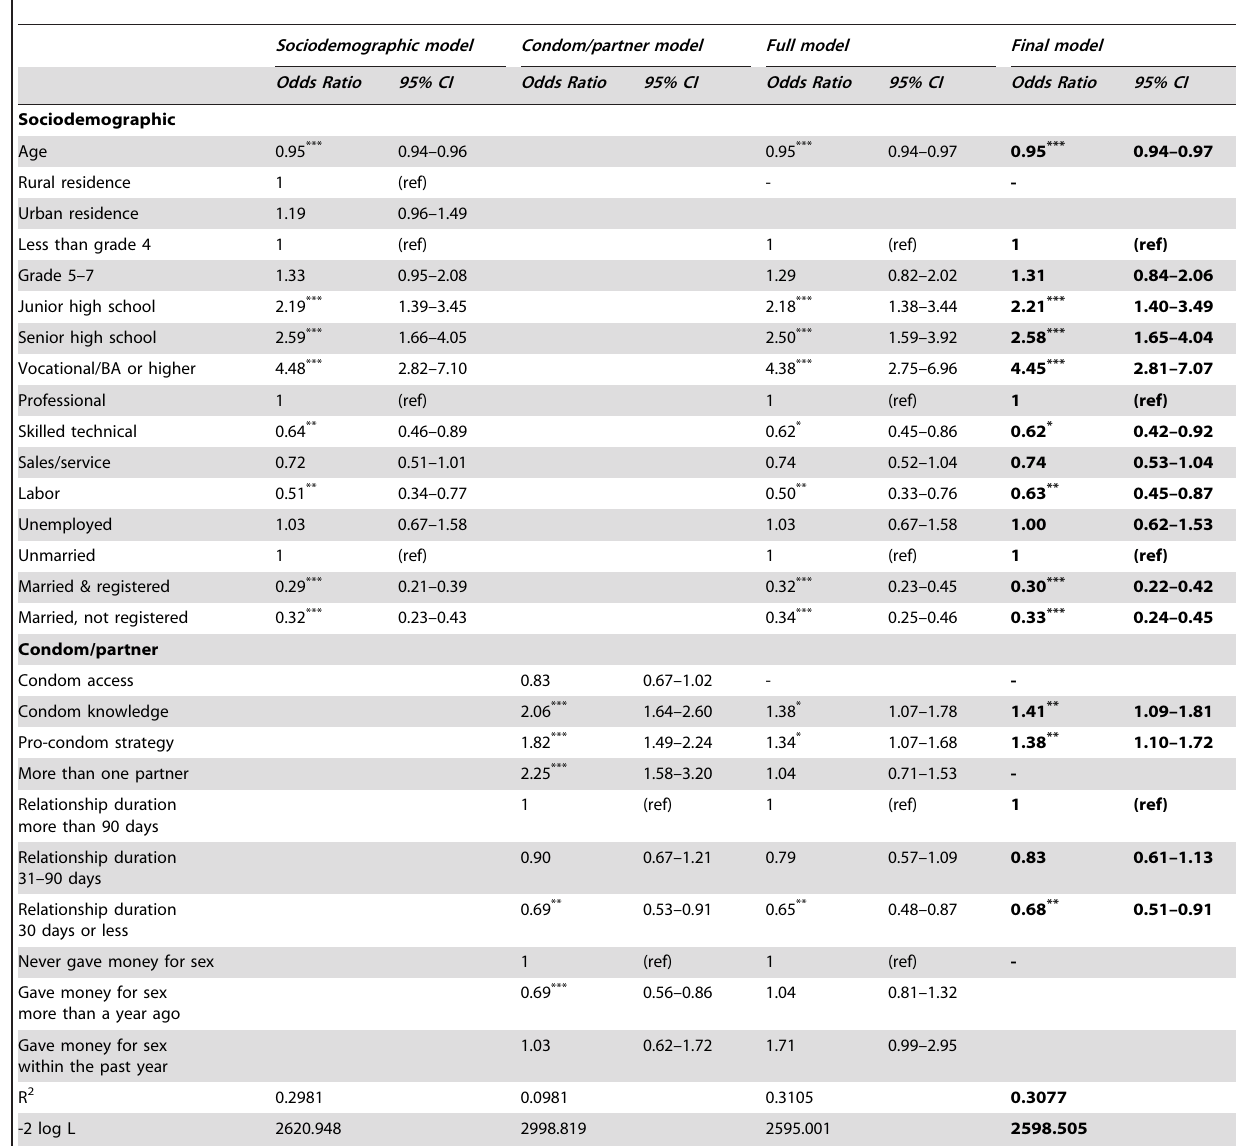
Table 4. Building the final proportional odds regression model to predict higher levels of condom use for men with regular partners in the 2006 National Sexual Behavior Survey of Thailand (N=